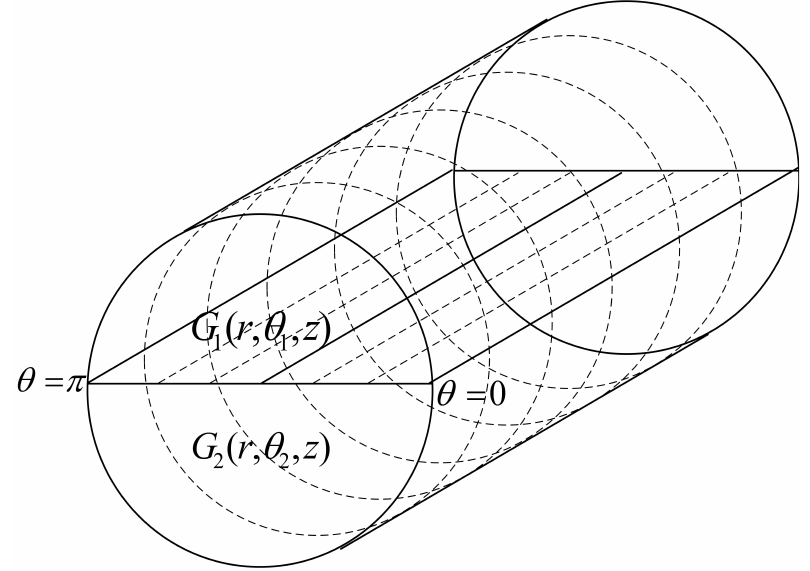
Figure 5. Regions formation in 2-chain based